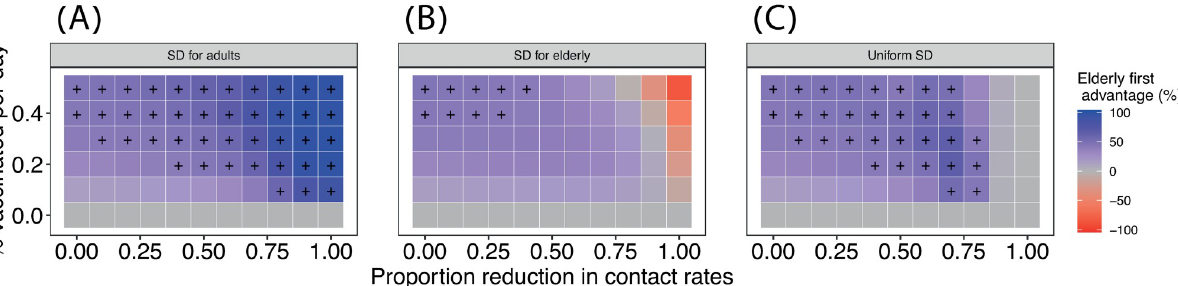
= ( H )/ H ; see text for explanation) for a given strength of H a − H e a are marked with a + sign. An example for the values H